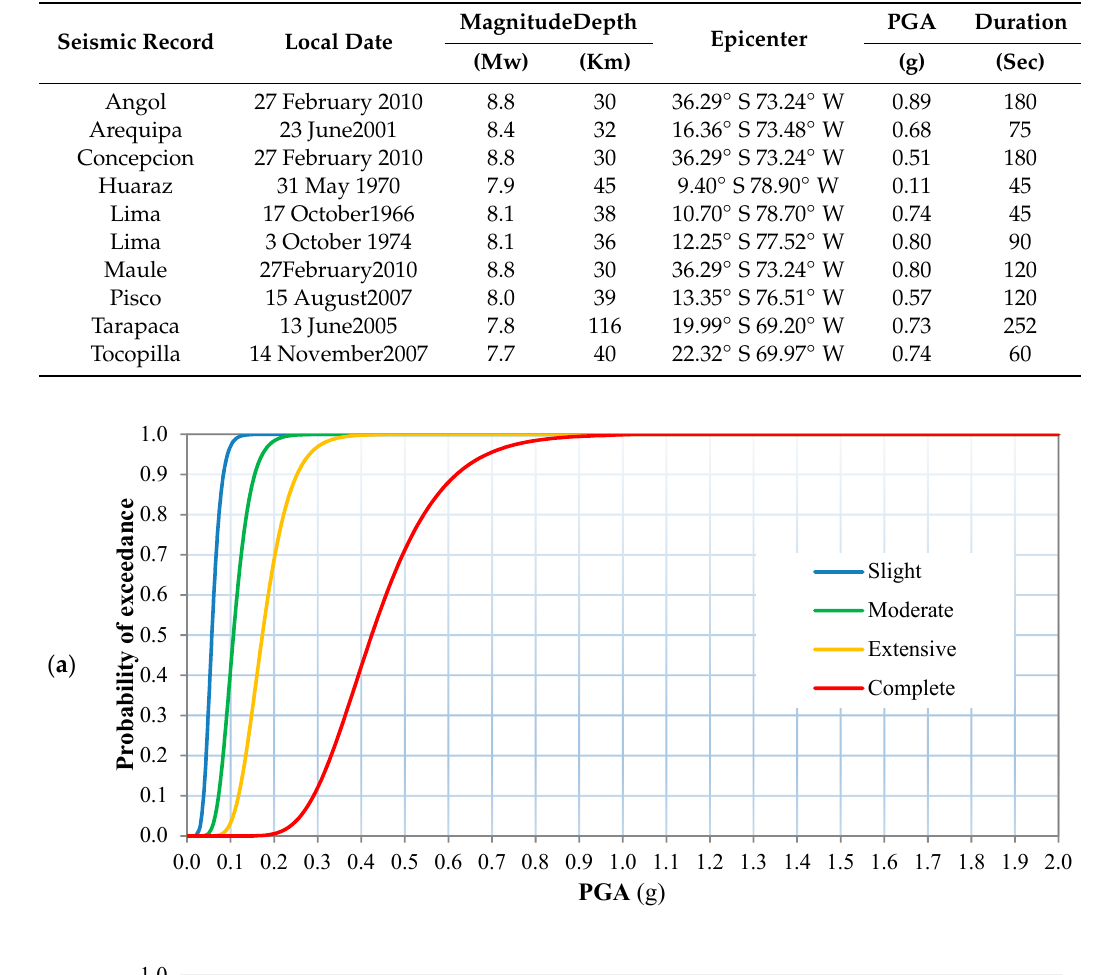
Table 3. Characteristics of the Considered Seismic Records.